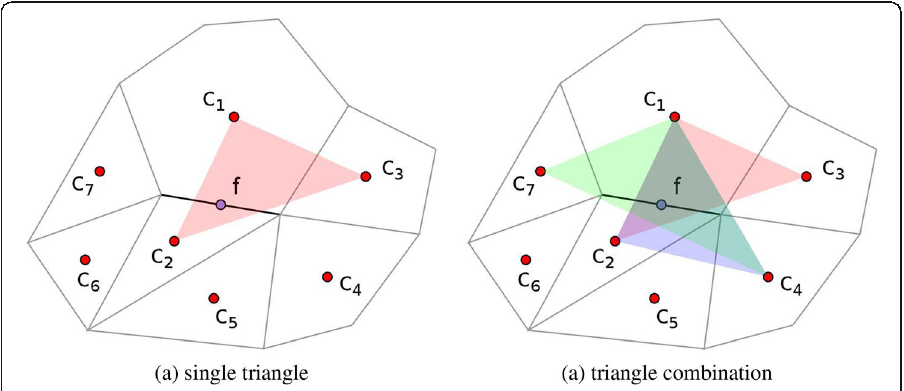
Fig. 17 Stencils for GG-WTLI method [8] ( a ) single triangle ( b ) triangle